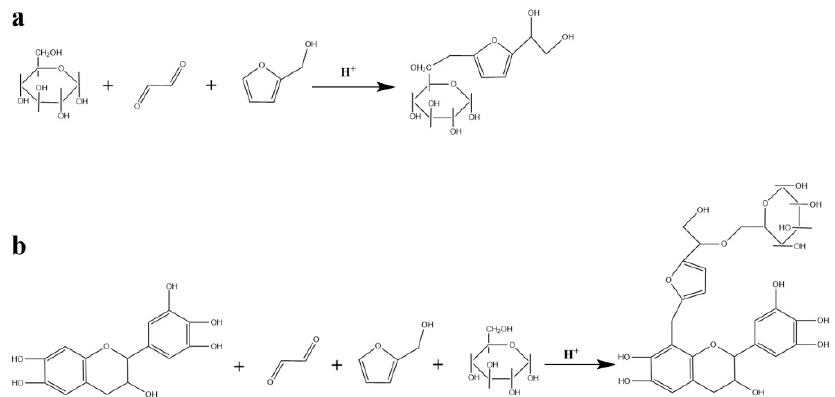
Figure 1. FTIR spectra of starch (S)-, tannin (T)-, tannin–starch–glyoxal–furfuryl alcohol (SGFA)-, and tannin–starch–glyoxal–furfuryl alcohol (TSGFA)-based